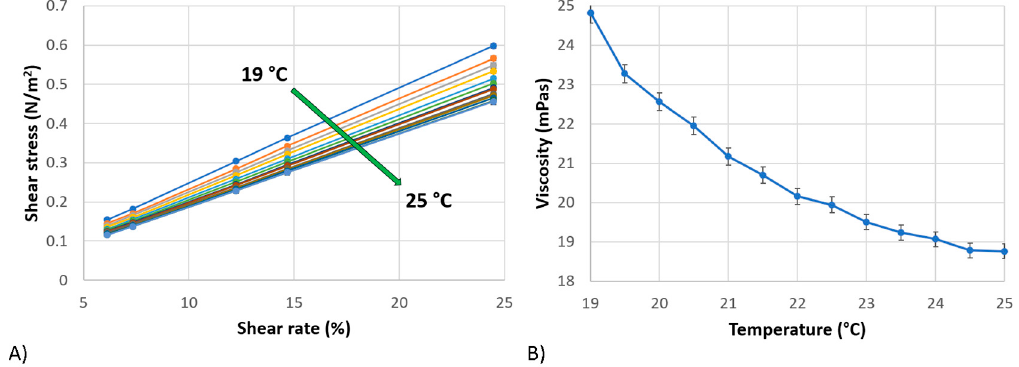
Figure 1. Schematic representation of the final prototype.